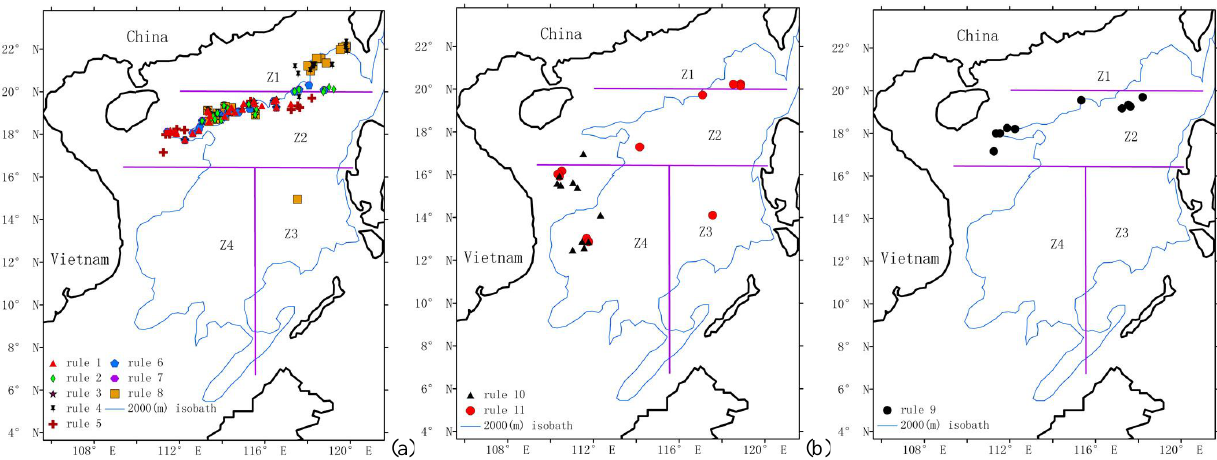
Fig. 7. Spatial distributions of typical states of two types of mesoscale eddy in (a) winter, (b) summer and (c) fall in the SCS extracted from Table 6. No state is extracted in spring. (Blue line is 2000m isobaths.)